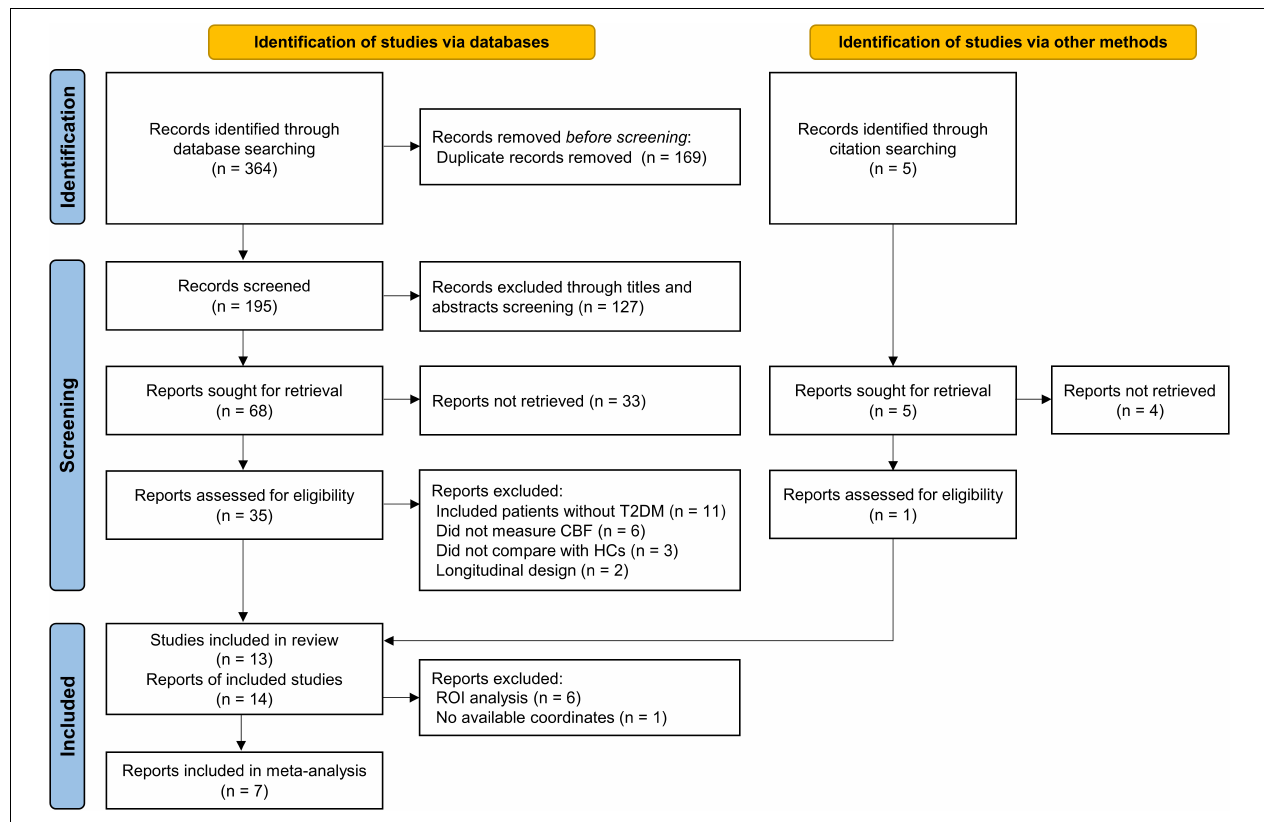
FIGURE 1 | PRISMA flow diagram for literature search and study selection. PRISMA, Preferred Reporting Items for Systematic reviews and Meta-Analyses; T2DM, type 2 diabetes mellitus; HCs, healthy controls; CBF, cerebral blood flow; ROI, region of